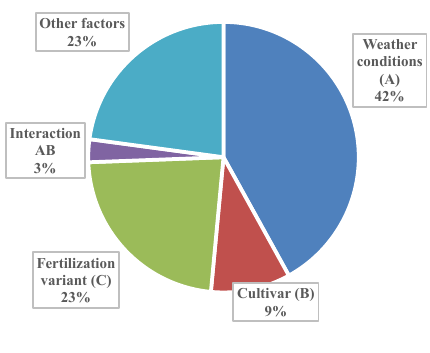
Figure 6 Factors affecting the formation of grain weight per spike.